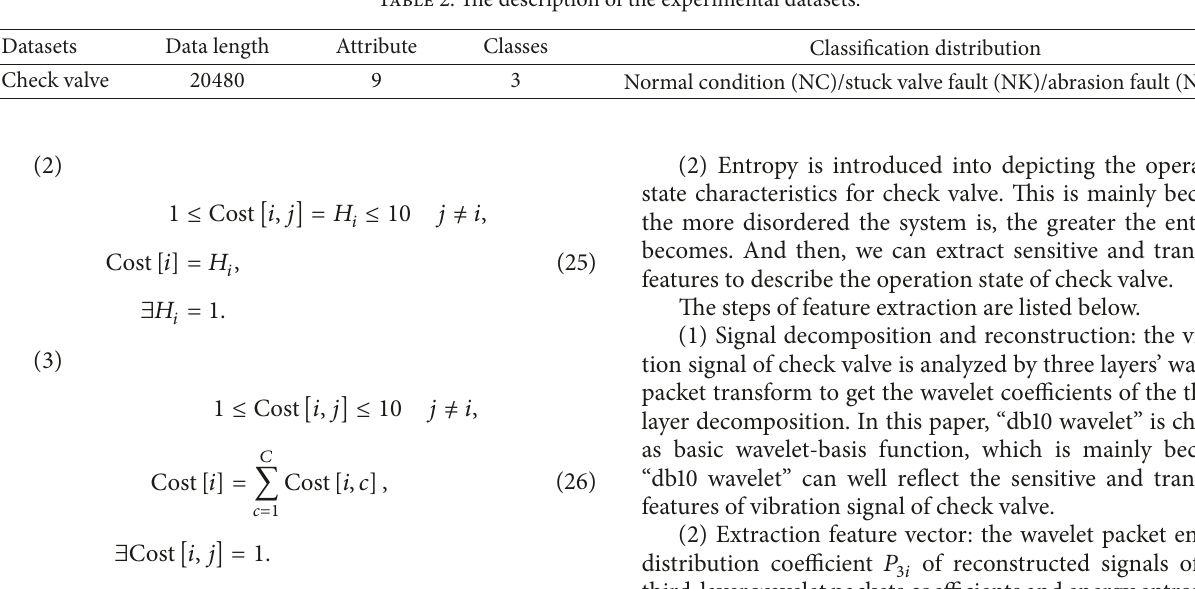
Figure 2: The high pressure diaphragm pump and fault check valve. Table 2: The description of the experimental